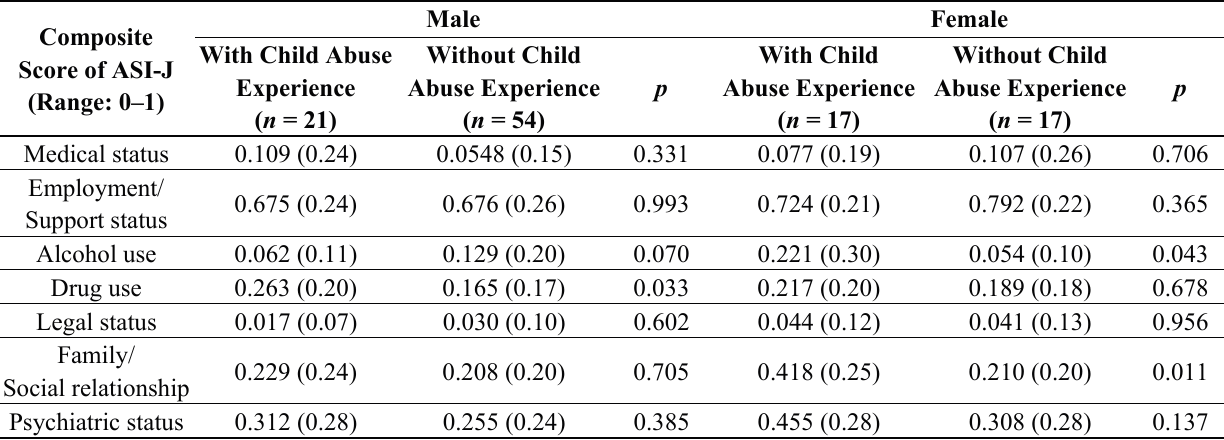
Table2. Comparison of the composite scores on ASI-J according to child abuse experience and